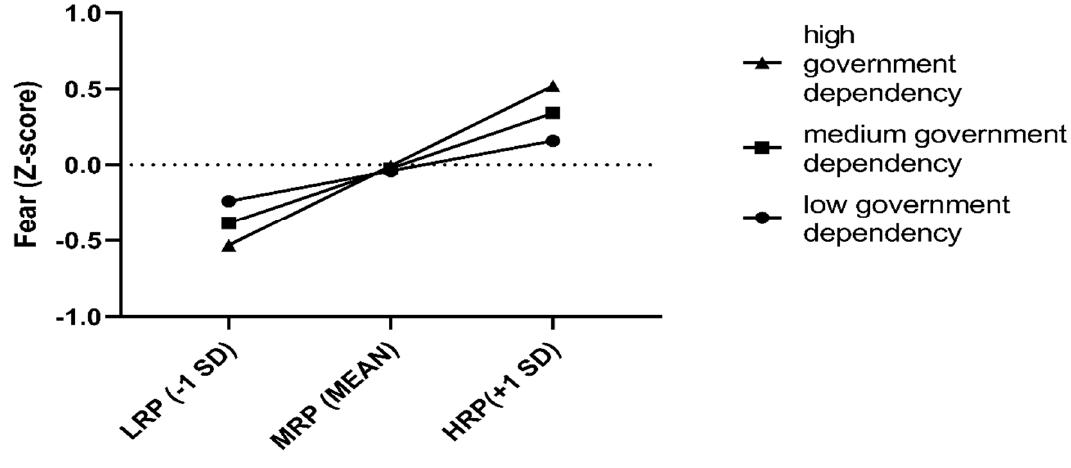
Figure 3. The interaction effect of risk perception and government dependency on fear.